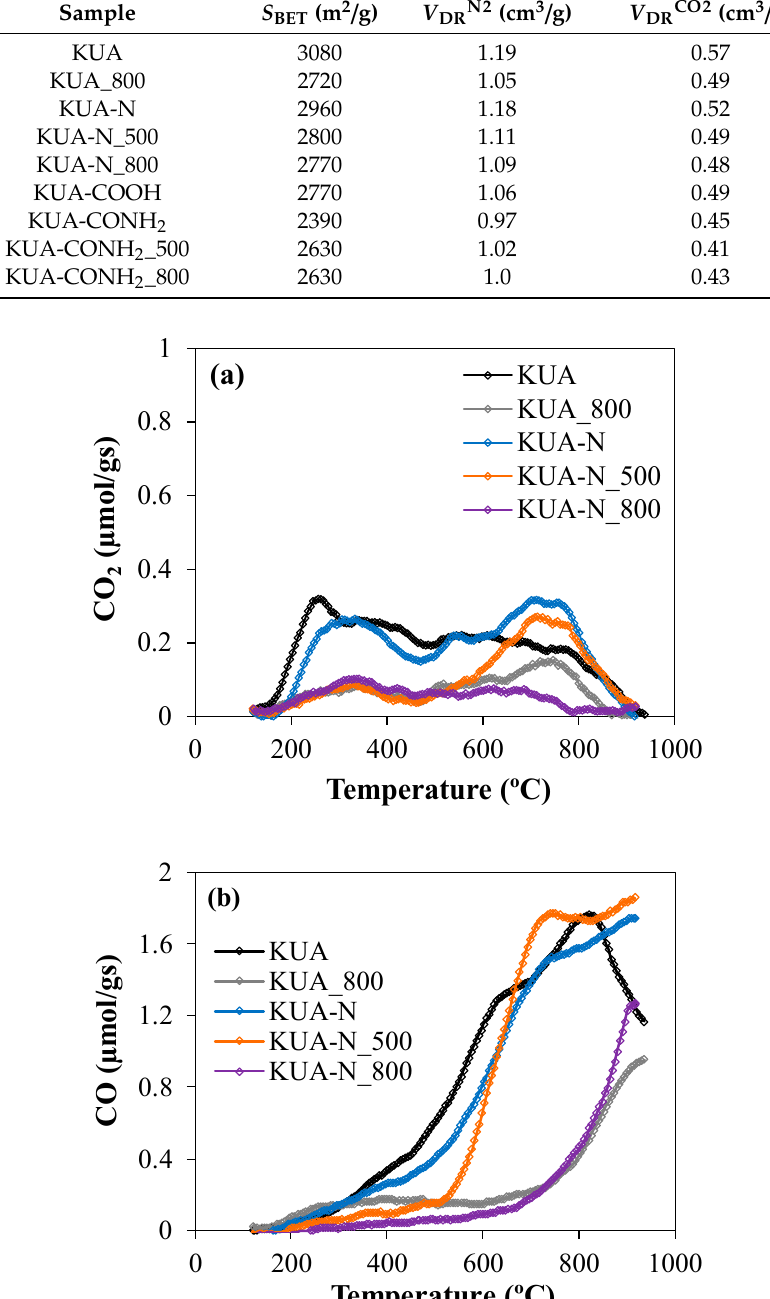
Table 1. Porous texture of the activated carbons.